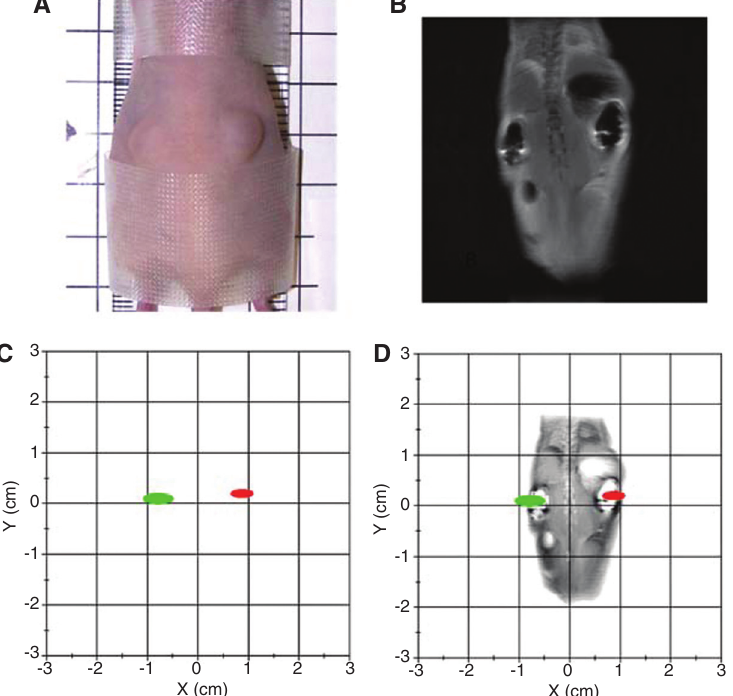
Figure 8 Imaging of a nude mouse with two xenograft MCF7/Her2–18 tumors injected with Her2-conjugated magnetic nanoparticles. (A) Photograph of the mouse on the relaxometry imaging stage. (B) T2-weighted MRI after intratumoral injection of nanoparticles (normal gray scale). (C) SQUID-detected magnetic relaxometry confidence intervals are centered at the positions of the detected dipole sources. The size of the confidence intervals indicates the uncertainty in the determination of the source position in the X and Y directions. (D) Co-registry of the relaxometry confidence intervals and the MRI (reverse gray scale). The MRI (4 cm FOV) was scaled to the correct size relative to the relaxometry coordinate grid. The MRI was then translated to the same origin used for the relaxometry measurement (X = 0 line coincides with the spine, Y = 0 line bisects tumors). (Reproduced with permission from Ref. [132], Copyright John Wiley and Sons,